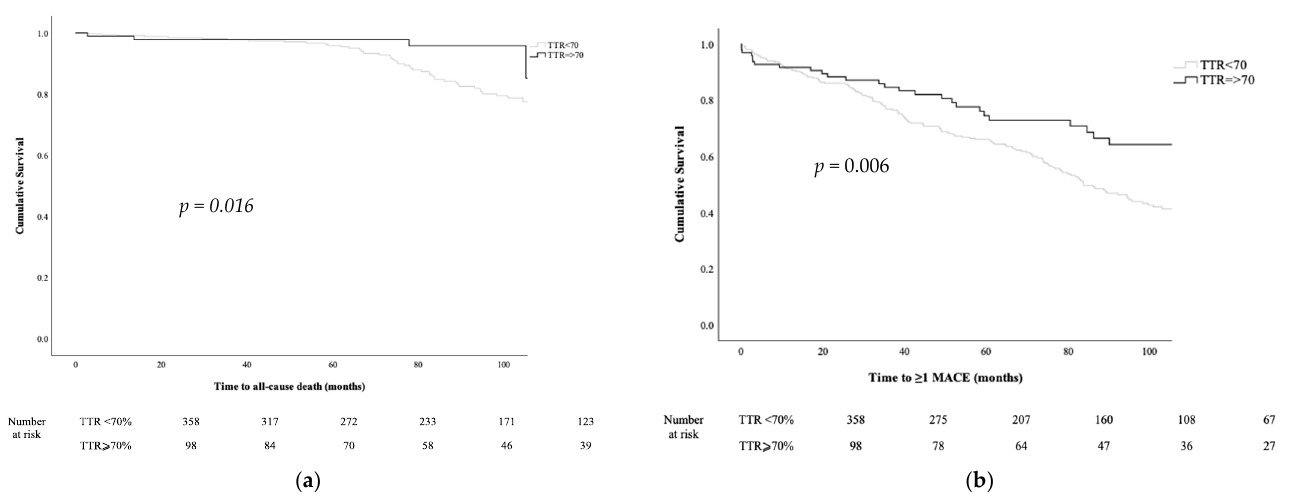
Figure 4. ( a ) Kaplan–Meier curves among operated VHD patients stratified by categories of TTR (TTR < 70% vs. TTR ≥ 70%) for all ‐ cause death. ( b ) Kaplan–Meier curves among operated VHD patients stratified by categories of TTR (TTR < 70% vs. TTR ≥ 70%) for composites of thromboembolic, bleeding event, cardiovascular hospitalisation and all ‐ cause death ( ≥ 1 MACE).